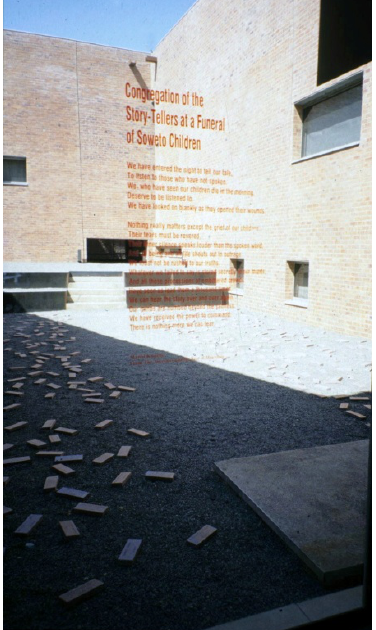
Figure 9. Window opening onto a memorial courtyard, with scattered bricks inscribed with the names of victims of the Soweto Uprising, Hector Pieterson Memorial and Museum, Soweto (author’s